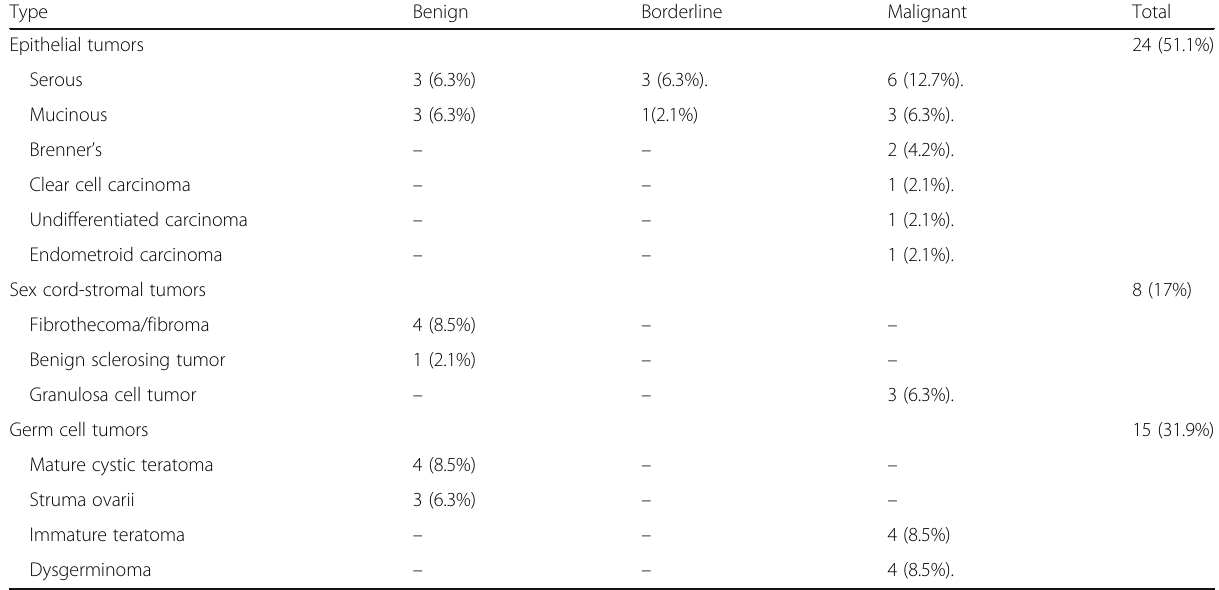
Table 8 Final post-operative histopathological